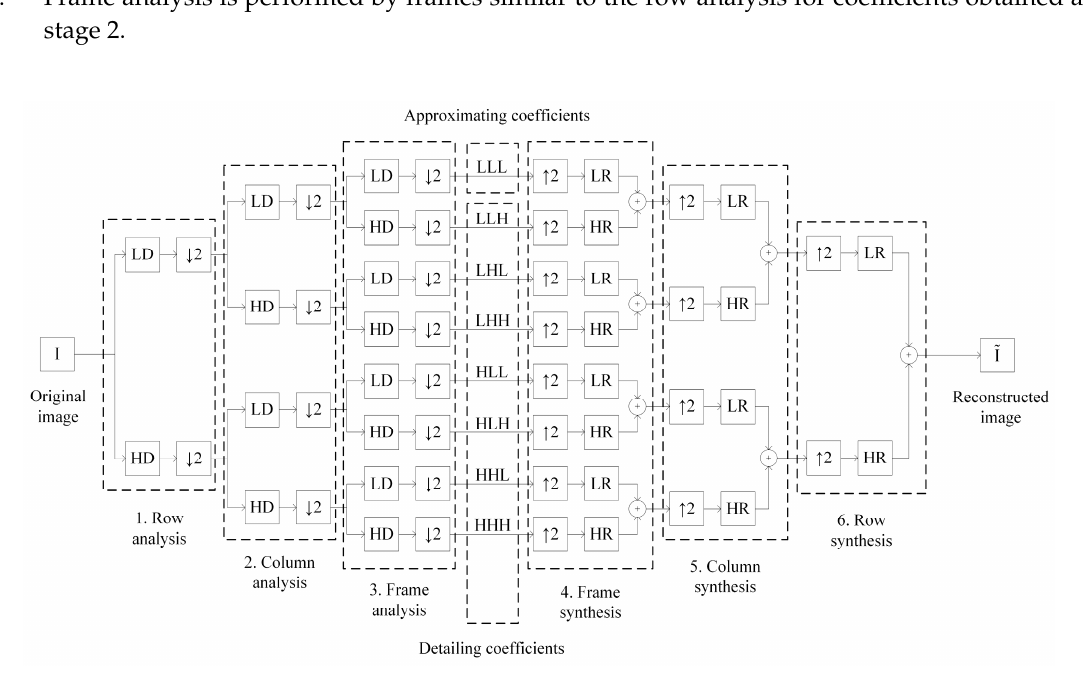
Figure 2. The scheme of 3D image discrete wavelet transform (DWT).